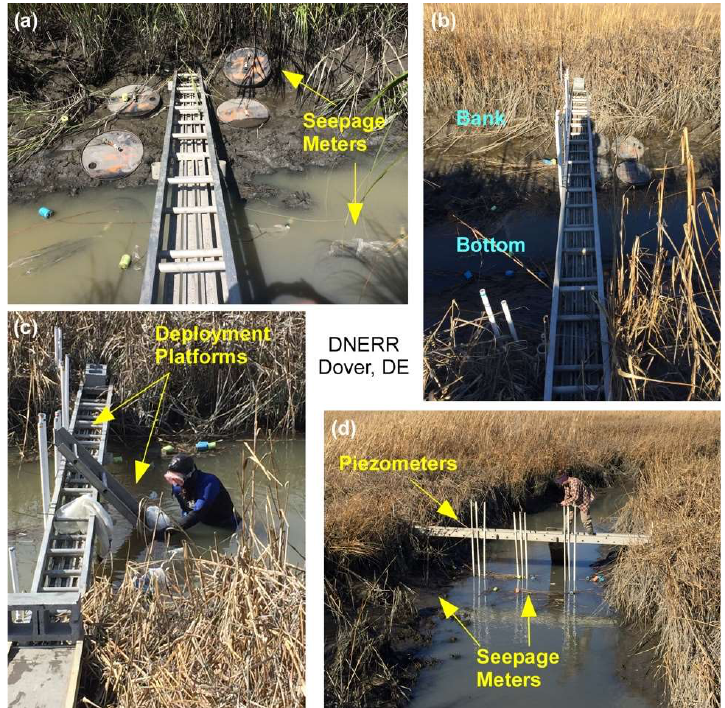
Figure 2. Example photographs of seepage meter campaigns in a Delaware salt marsh. Photos show ( a ) and ( b ) seepage meters installed in a creek bank and channel bottom with a ladder across the marsh; ( c ) a closer look at the ladder across the creek and a second ladder for access to the seepage meters; and ( d ) a perpendicular view of the ladder set-up and additional piezometer in-